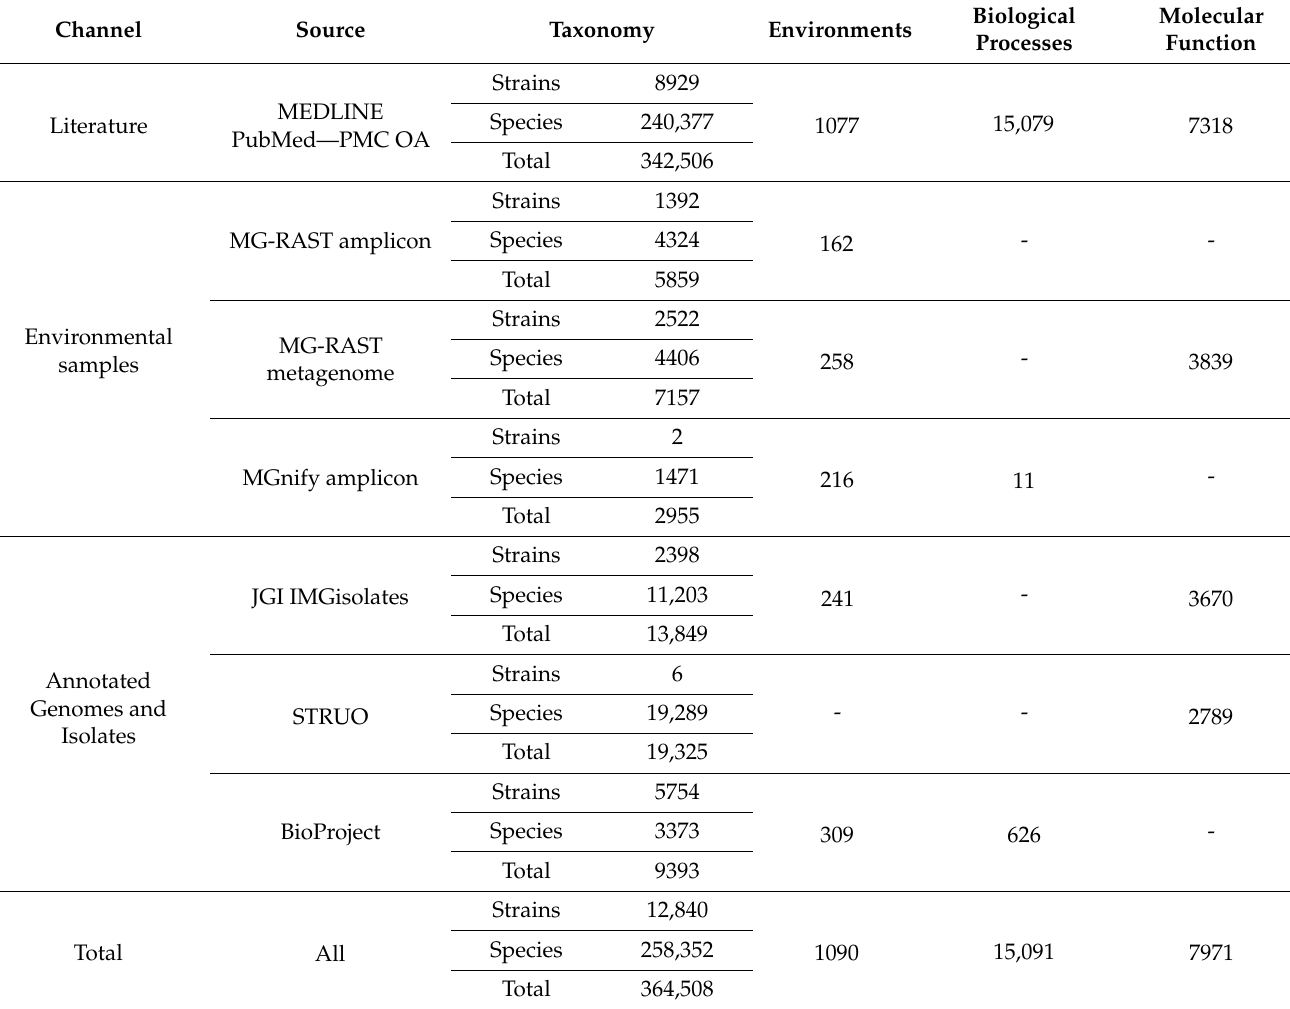
Table 2. The entities of PREGO after the NER and mapping of every source: Counts of distinct entities of Taxa, Environments (ENVO terms), Biological Processes (Gene Ontology Biological process), and Molecular Function (Gene Ontology Molecular